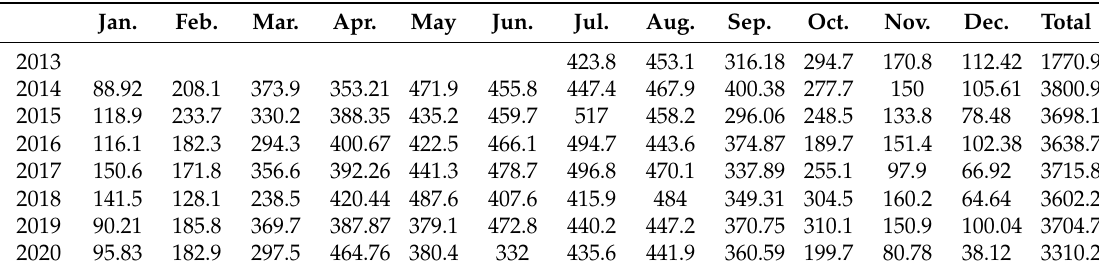
Table 6. Total yield (MWh).